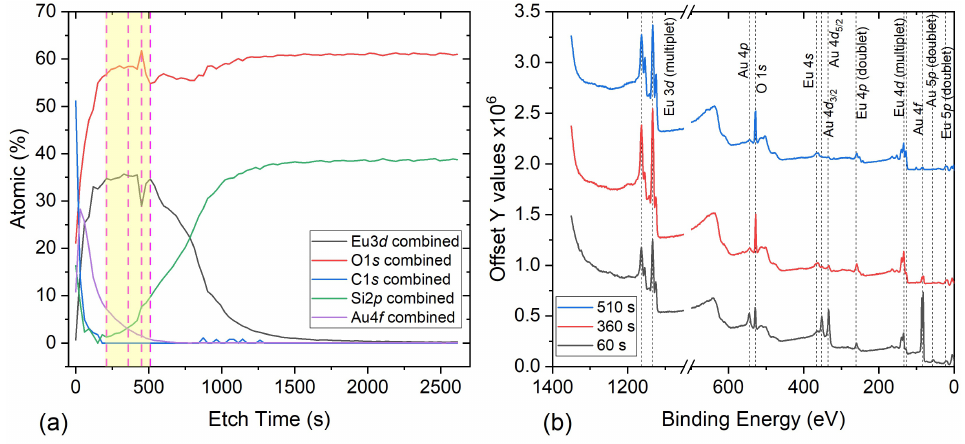
Figure 5. ( a ) XPS etch profile of the Si/SiO 2 /Eu 3 O 4 /Au sample by Ar + plasma etching. The yellow shaded region highlights the area considered for the analysis of Eu cations, whereas the dashed vertical lines indicate t = 210 s, 360 s, 450 s and 510 s. ( b ) The XPS survey spectra of the Si/SiO 2 /Eu 3 O 4 /Au sample, collected at t = 60 s, t = 360 s and t = 510 s, highlighting the Au, Eu and O peaks.